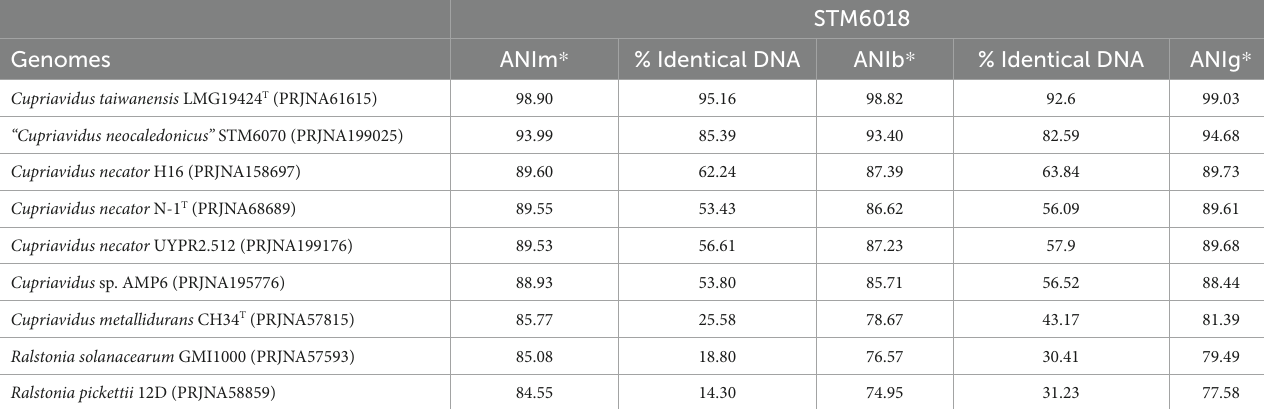
TABLE 1 Average nucleotide identities * (ANI) of STM6018 genome compared to close